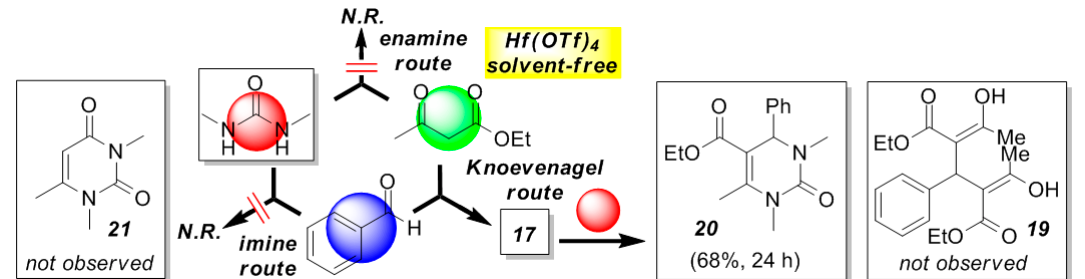
Figure 2. Mechanism variation for N , N ′ -dimethylurea-based Biginelli reaction.